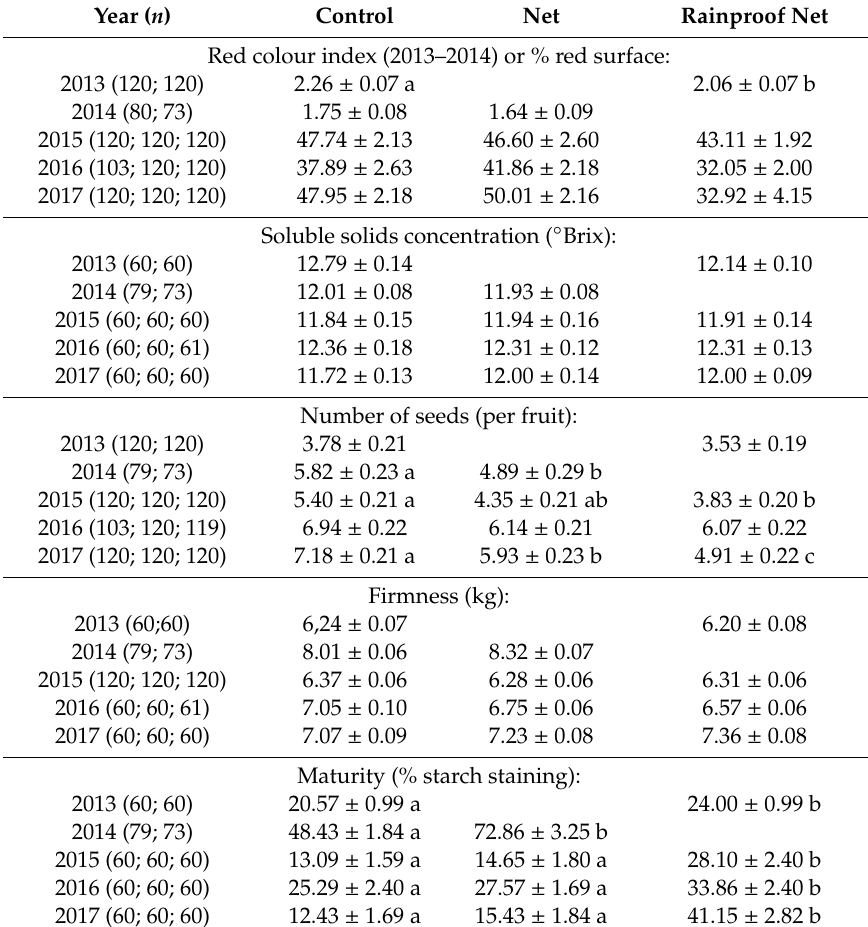
Table 3. Fruit quality measurements (colour, soluble solids, number of seeds, firmness and maturity) (mean ± SE, n = total number of observations) for fruits harvested from row units without nets, with nets, and with rainproof nets. Di ff erent letters indicate statistically significant di ff erences between treatments for appropriate years (Tukey tests except for nonparametrical red colour indices which required a Dunn test + Bonferroni correction, p <